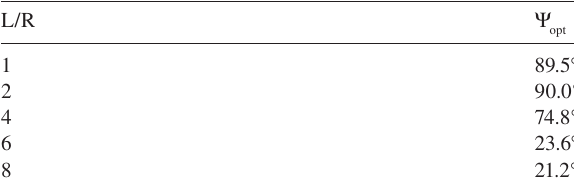
Effect of skew angle on the optimum fi ber orientations.